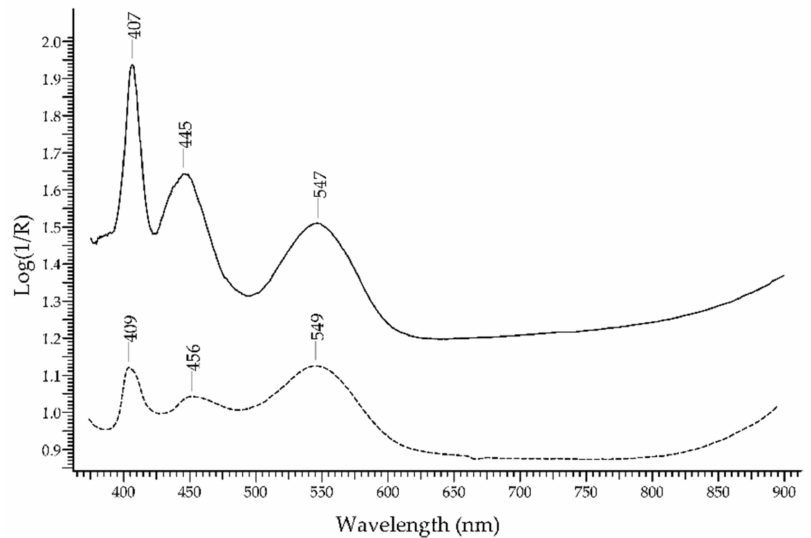
Figure 10. FORS spectra in Log(1/R) coordinates of rhodochrosite (solid line) and rhodonite (dashed